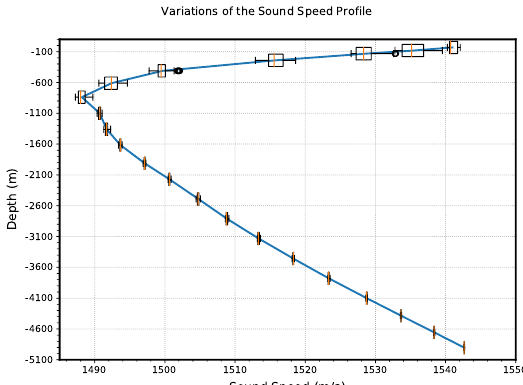
Figure 3. Sound Speed Profile (SSP) used in the simulations. All the two-way-travel times τ were generated with this profile. The box plots represent the level of noise used to perturb the TWT times τ at each epoch, depending on the